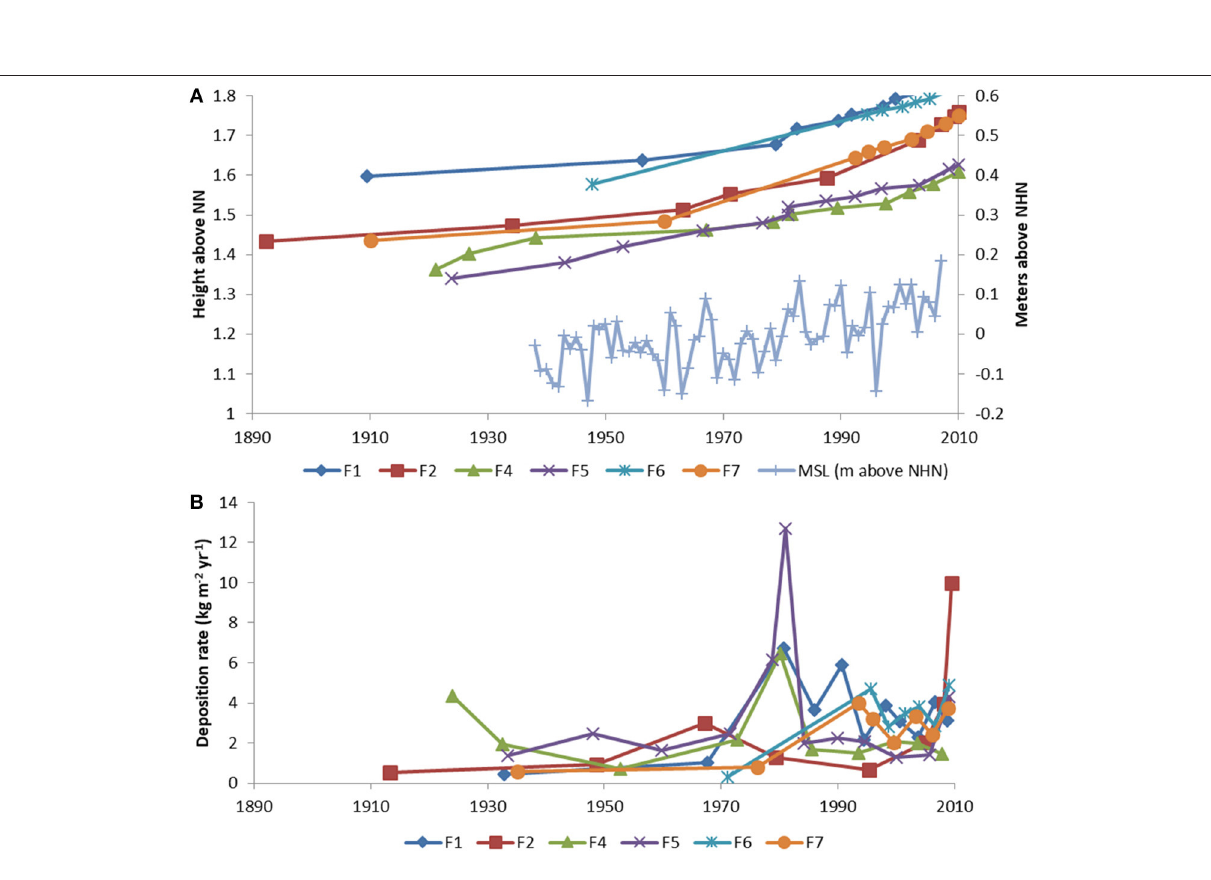
Frontiers in Marine Science | www.frontiersin.org